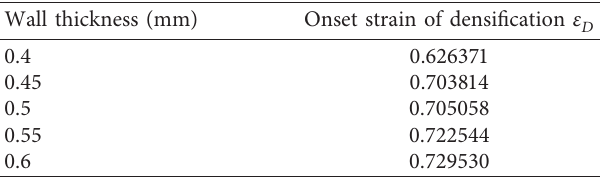
Table 3: Onset of densification under different thicknesses of wall.